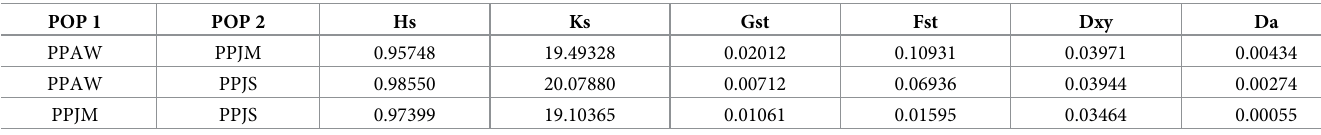
median joining networks utilizing these genes indicate any clear population structuring. PpSP12, PpSp14, and PpSP15 belong to the family of small odorant-binding proteins (OBP) but their specific functions are unknown. Phlebotomus OBPs are related to the D7 Table 9. PpSP28 pairwise comparisons of genetic differentiation